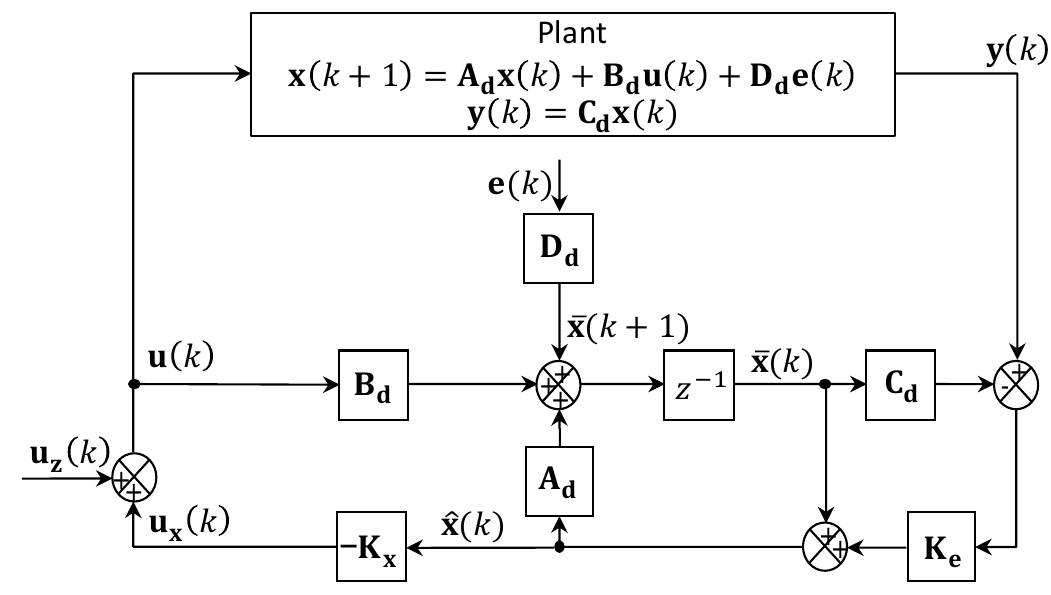
Figure 4. State feedback control using current full-state observer in the discrete-time domain.